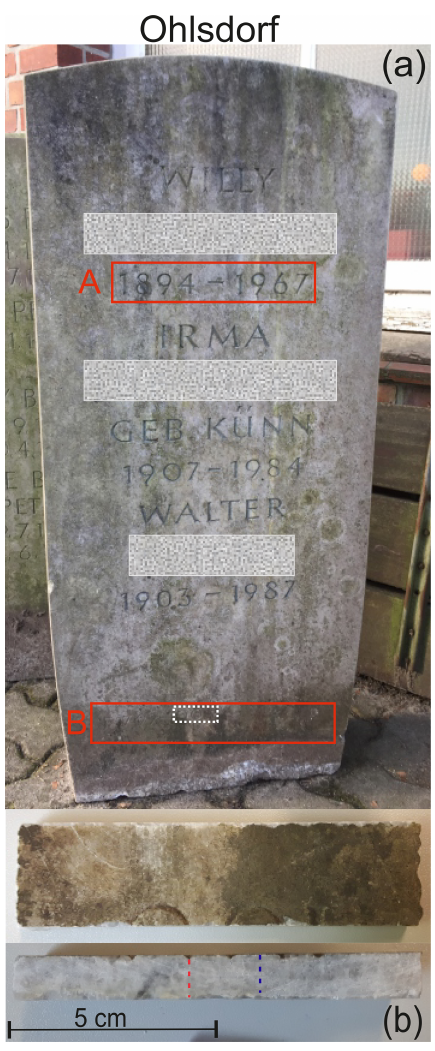
Figure 2. (a) Photograph of engraved gravestone (MaD1) from Ohlsdorf (Hamburg Germany); the solid red rectangular lines mark the areas from which samples were cut, where A and B de- note cuts from the upper and bottom part of the gravestone (e.g. MaD1A and MaD1B, respectively). (b) Top and side view of sample MaD1B_C4, corresponding to the dashed white rectangle in (a) . The dashed red and blue lines in (b) trace the measured line profiles beneath and away from inscriptions, respectively.